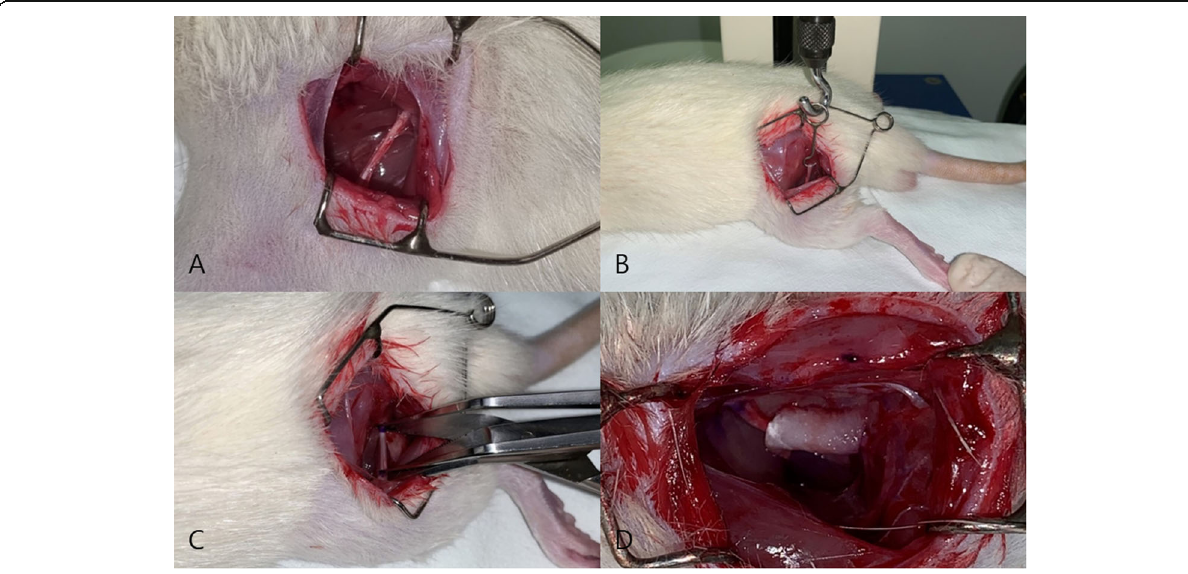
Fig. 2 Surgical procedures. A Exposure of the sciatic nerve of a rat. B Precise traction injury performed in the left sciatic nerve of the rat. C Measurement of the elongated sciatic nerve after traction injury. D Application of FK506 loaded with collagen membrane and fibrin glue on the injured sciatic nerve of a